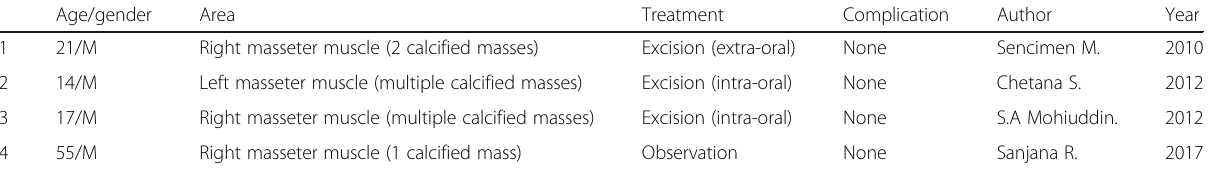
Table 1 Cases of dystrophic calcification in masseteric area have been